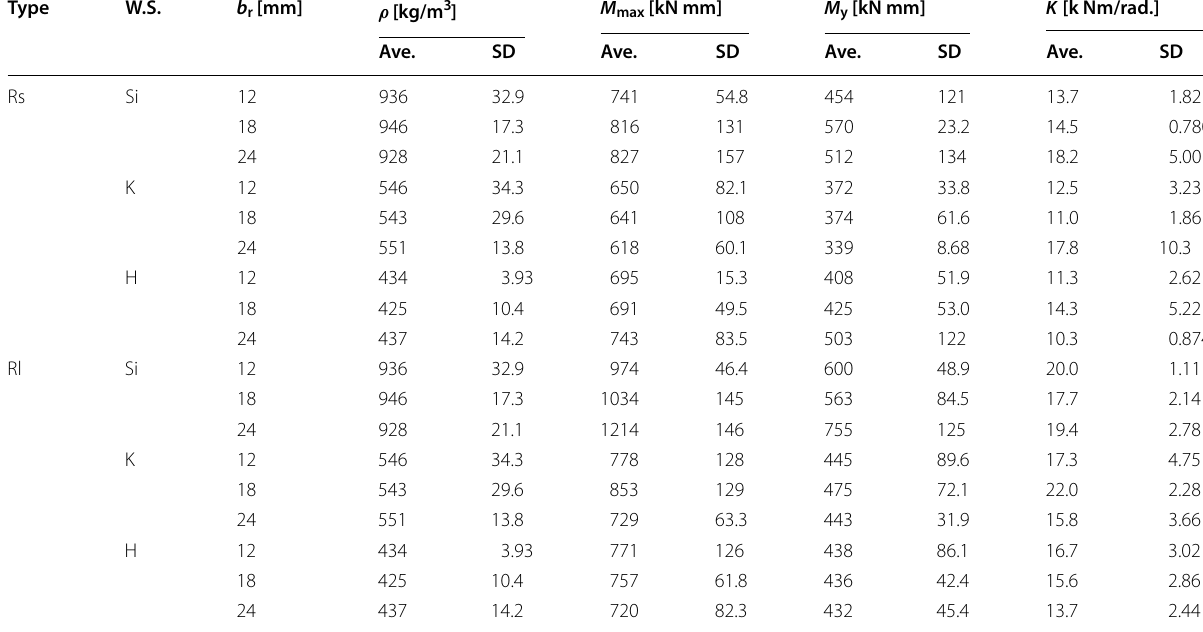
W.S., wood species of reinforcements (Si, K, H and Su represent shirakashi, kuri, hinoki and sugi, respectively), b r : see Fig. 1; ρ , density of reinforcements; M max , maximum moment; M y , yield moment; K , elastic rotational stiffness; Ave., average; SD, standard deviation